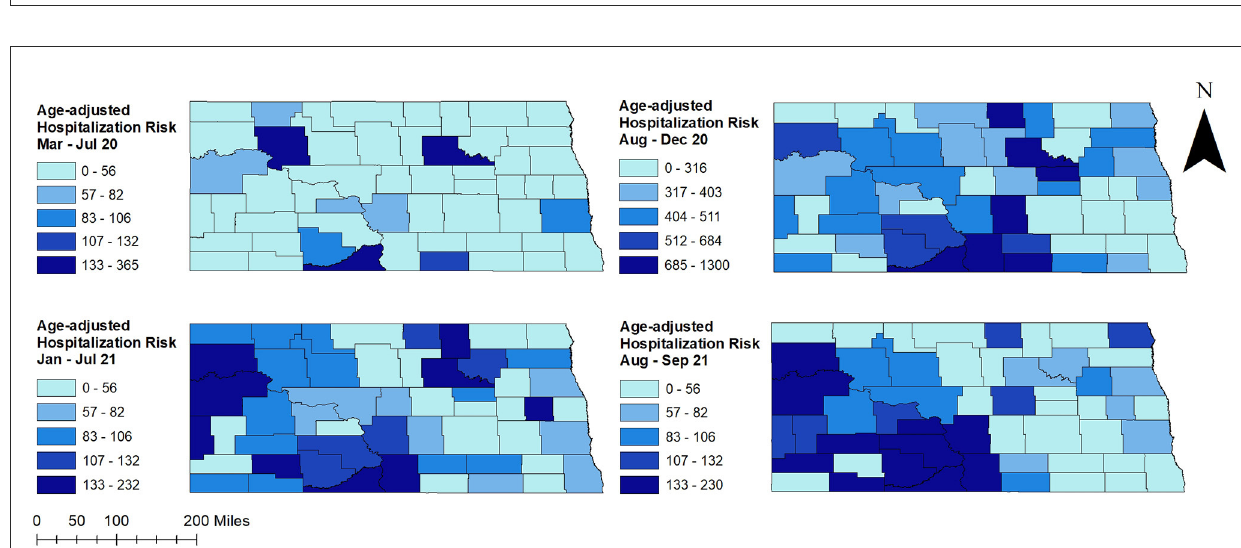
FIGURE2 County-level unsmoothed age-adjusted COVID-19 hospitalization risks in North Dakota, March 2020–September 2021.